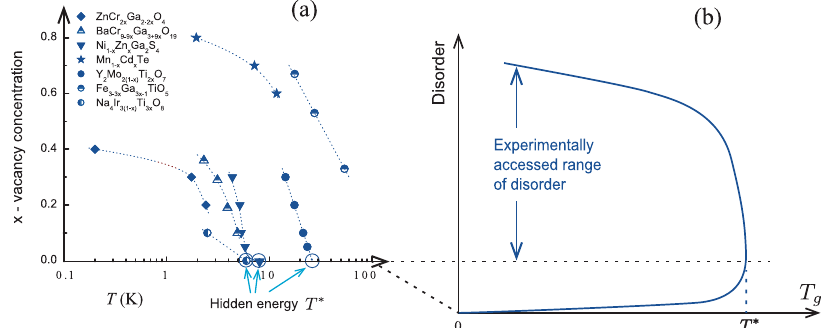
Fig. 2 The dependencies of the glass transition temperatures T g on the amount of disorder in geometrically frustrated systems. a The dependencies for real materials following from the available experimental data analysed in this work. The non-vanishing of T g in the limit of vanishing disorder for NiGa 2 S 4 , Na 4 Ir 3 O 8 and Y 2 Mo 2 O 7 suggests the existence of a hidden energy scale T *. b The dependence proposed here for a broader range of disorder. The upper part of the curve ( “ experimentally accessed range of disorder ” ) illustrates the experimental data analysed in this work. The lower part, for weaker disorder, is